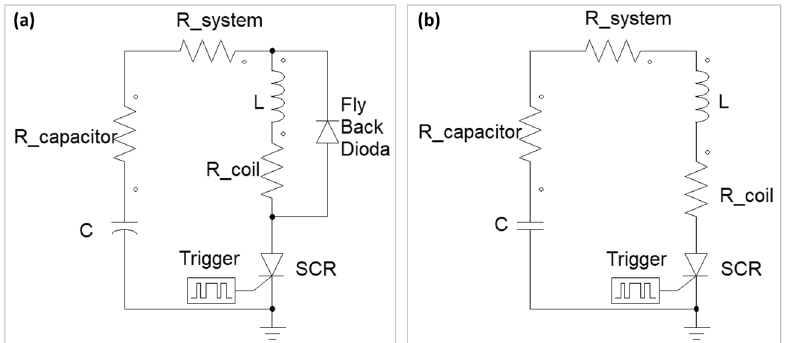
Figure 2. Electrical schematic diagram of ( a ) typical ignition circuit and ( b ) fast discharge energy recycling ignition